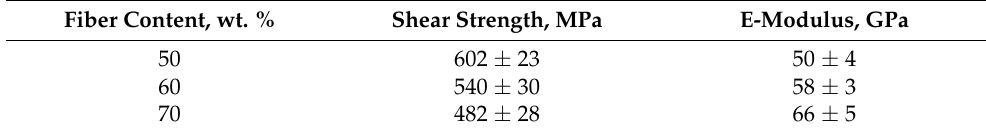
Table 1. Results of flexural strength tests. Fiber Content, wt. % Shear Strength, MPa